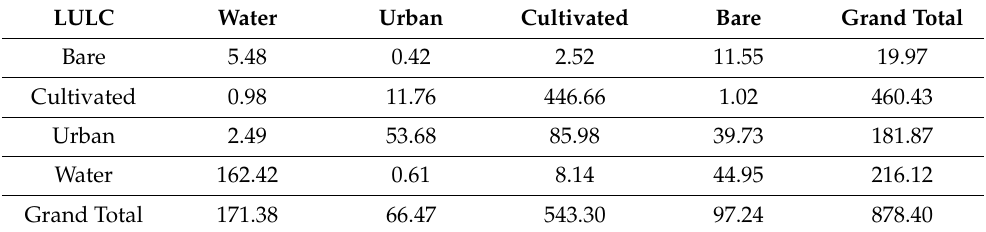
Table 8. Transition of LU/LC (km 2 ) from 2001–2021.